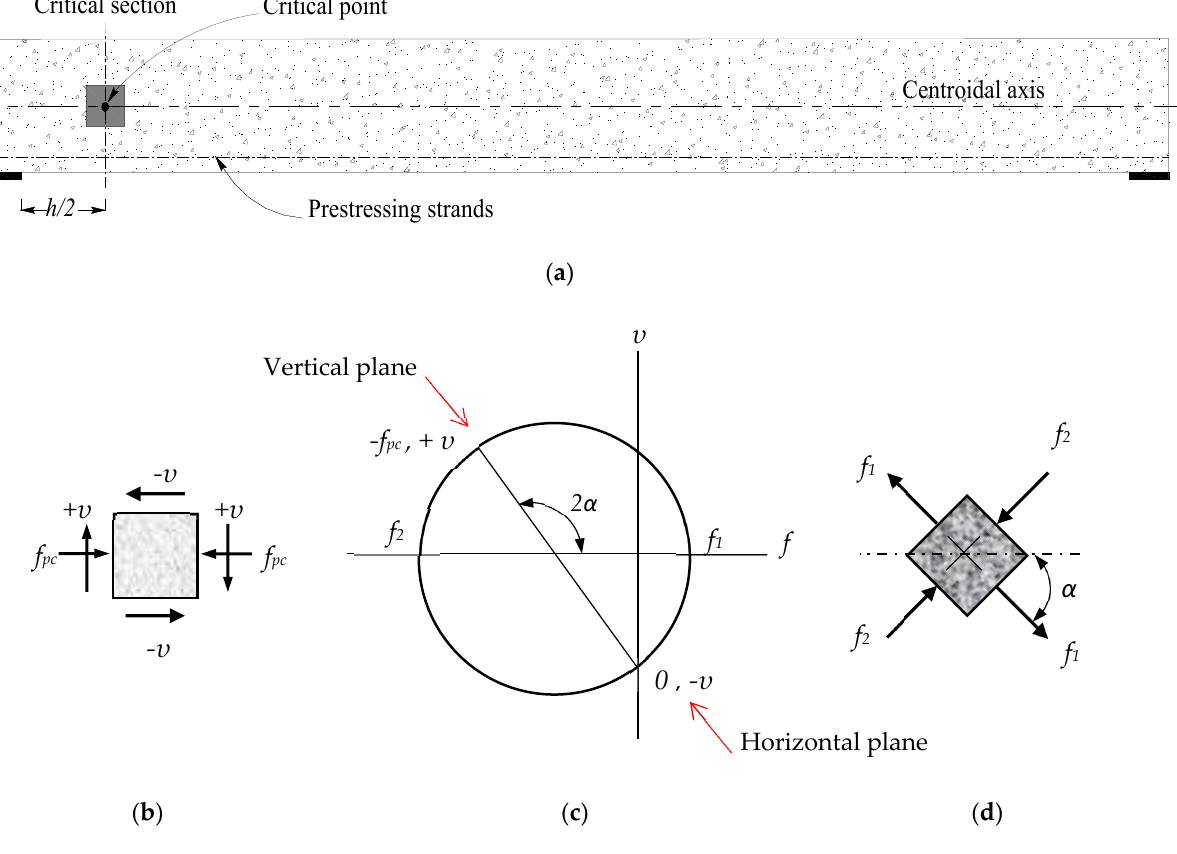
Figure 3. Stress state in an element near the support. ( a ) HCS elevation, ( b ) element stresses; ( c ) Mohr’s stress circle, and ( d ) element principal stresses.